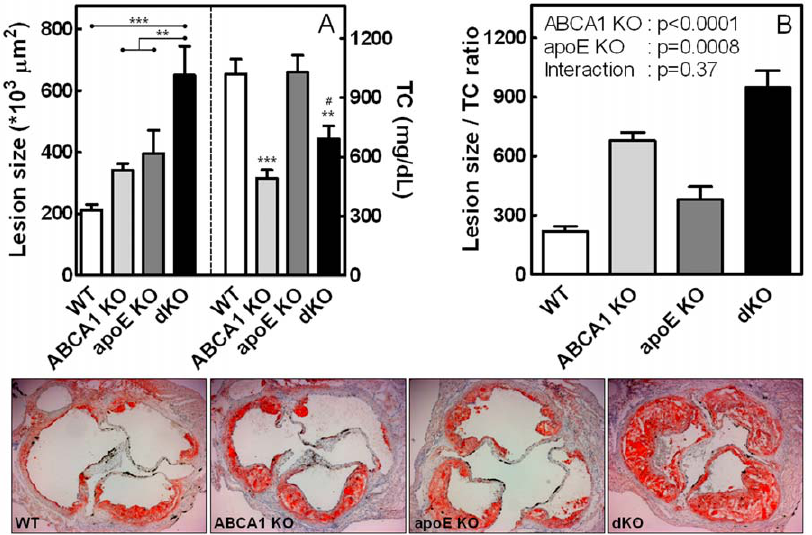
Figure 6. Analysis of atherosclerosis in the aortic root of bone marrow transplanted LDLr KO mice after 9 weeks of HF/HC diet feeding. Quantification of atherosclerotic lesion sizes in the aortic root and TC levels in bone marrow transplanted LDLr KO mice after 9 weeks of HF/ HC diet feeding (A). Lesion size divided by TC levels show cholesterol independent effects on lesion development (B). Representative cross-sections, stained with oil red-O (magnification 50 6 ; lower panels).Values are the means of 10 aortic root sections of individual mice (n $ 11 mice 6 SEM per group. **p , 0.01, ***p , 0.001 as compared to WT transplanted controls, # p , 0.05 as compared to ABCA1 KO transplanted animals.